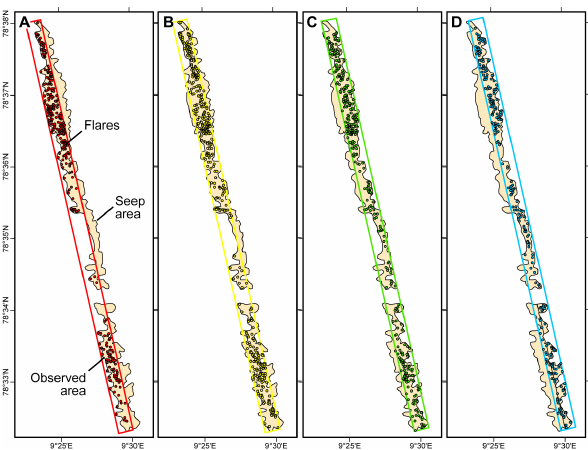
Figure 9. Diagram illustrating the approach of quantifying flares in Area 3. Numbers of flares were estimated within the “observed area”, which is the region covered by multibeam (rectangular box) intersecting with the “seep area”. Occurrences of flares were re- peatedly determined along four parallel profiles (a–d) as indicated in Fig. 8 and summarized in Table